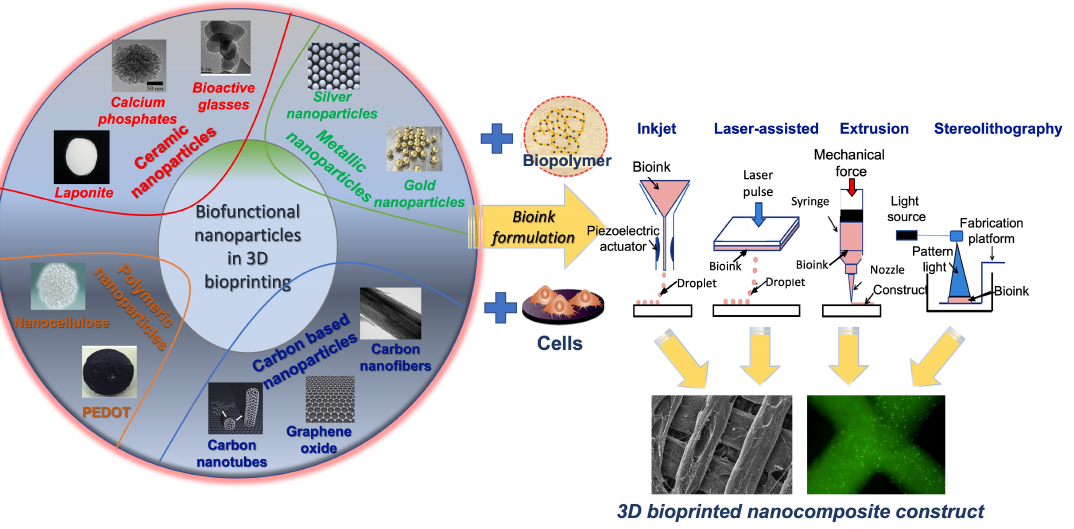
Figure 1. Schematic showing the different types of nanomaterials (ceramic-, metallic-, polymeric-, and carbon-based) that can be combined with biopolymers and cells resulting in 3D-bioprinted nanocomposite constructs by means of the printing methods including inkjet, laser-assisted, extrusion-based, and stereolithography.